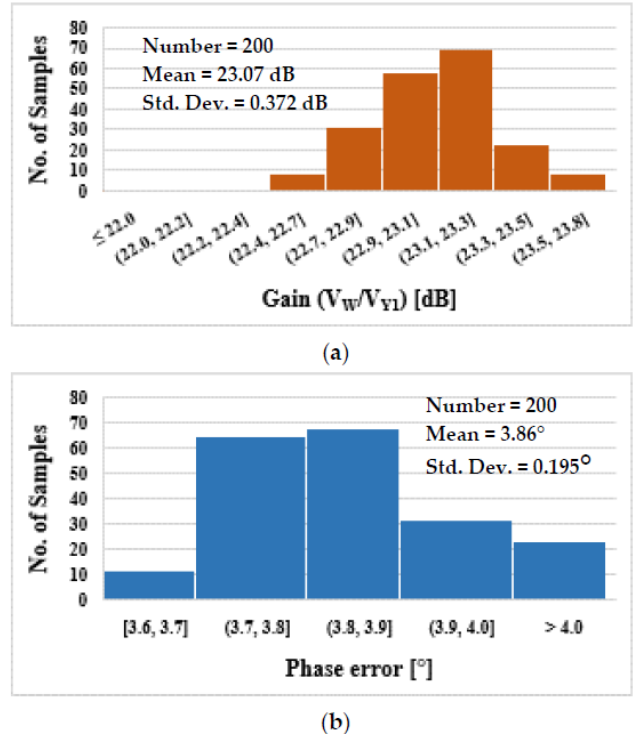
Figure 10. The DDCC histogram of the gain V w /V Y1 ( a ), V w /V Y2 ( b ), and the − 3 dB BW V w /V Y1 ( c ), and V w /V Y2 ( d ).